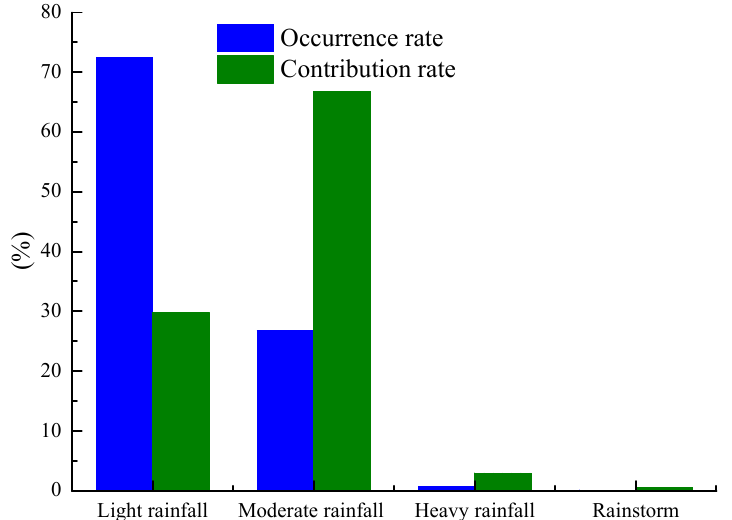
Figure 6. Distribution of the incidence and contribution rates of different rainfall intensity grade during the RS in the LP.